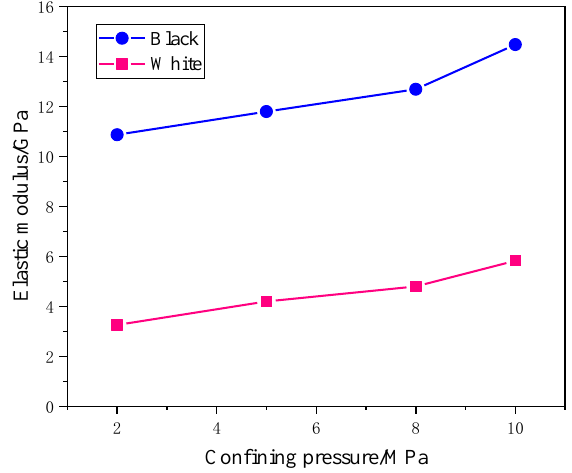
Figure 12. Elastic modulus of SMS specimens.